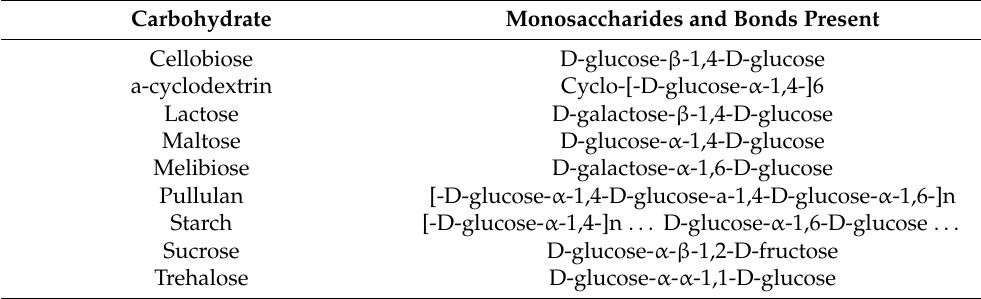
Table 2. Substrate specificity of